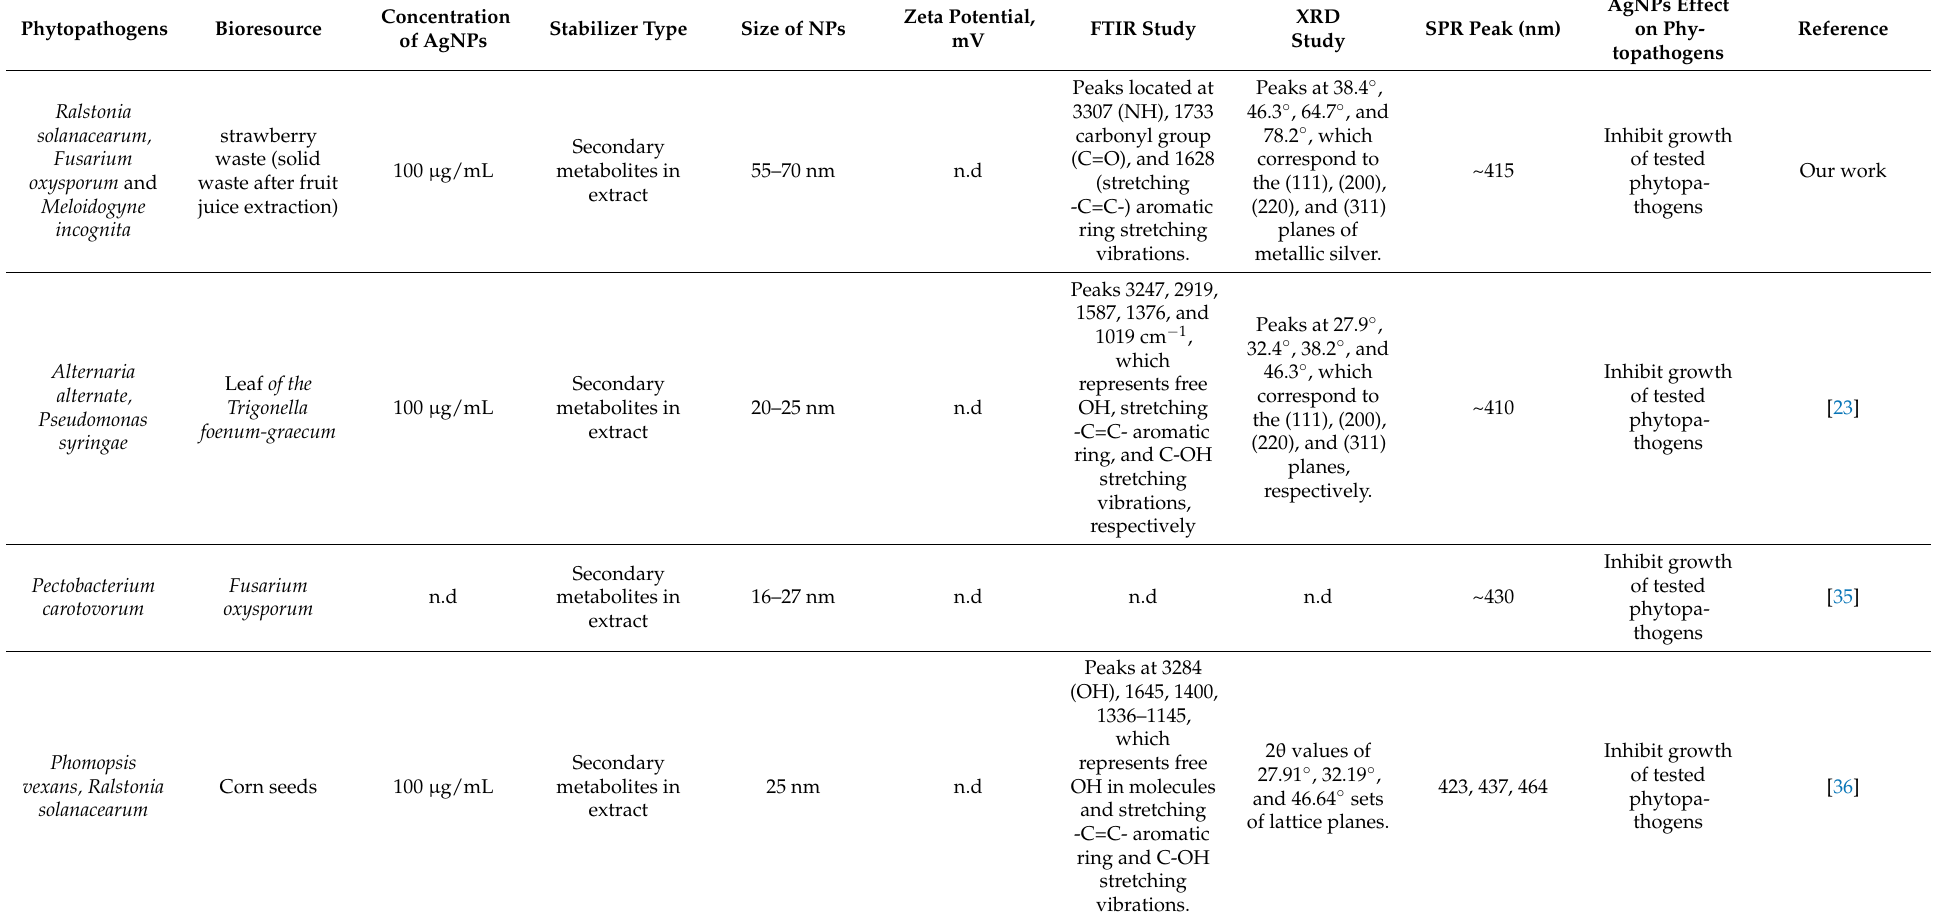
Table 1. Effect of AgNPs on